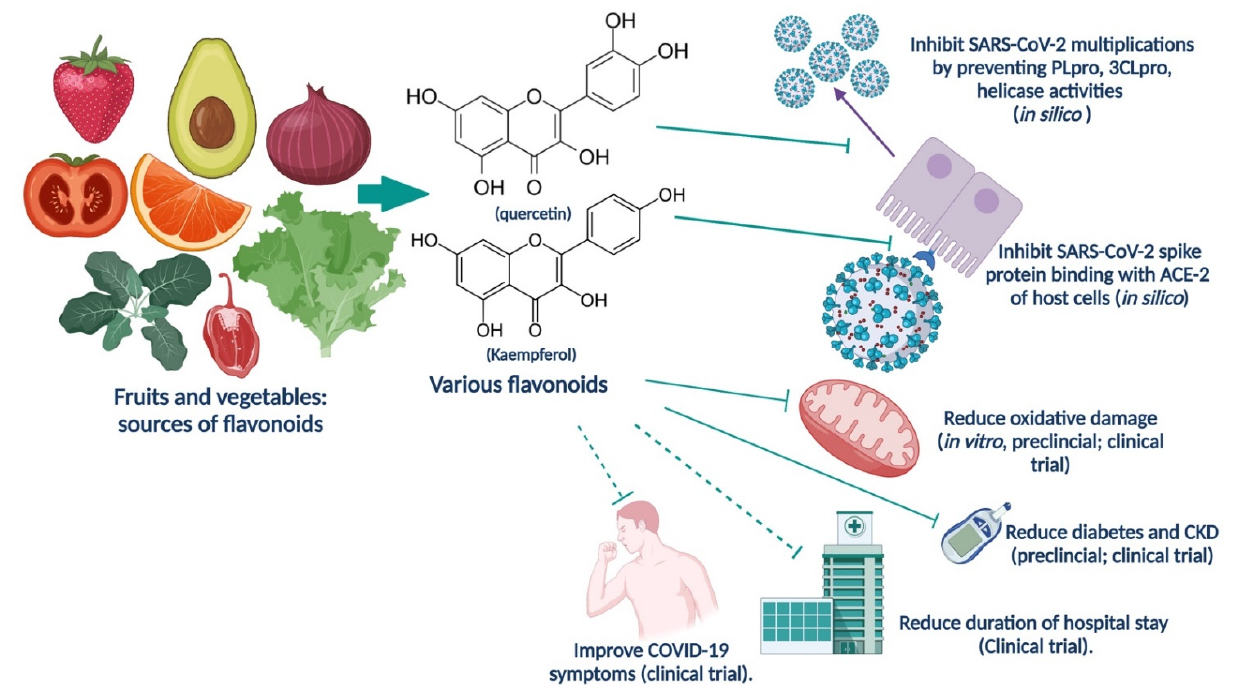
Figure 3. Roles of flavonoids against SARS-CoV-2 based on recent in silico, pre-clinical, and clinical studies. Abbreviations: CKD, chronic kidney disease; SARS-CoV-2, severe acute respiratory syndrome coronavirus-2; COVID-19, coronavirus disease 2019. (The figure was made with www.biorender.com, accessed on 13 December